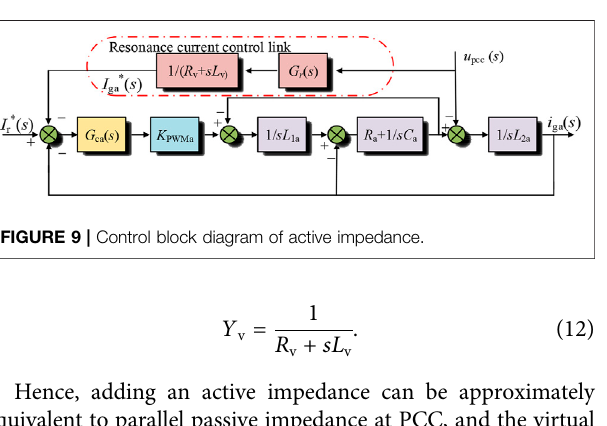
FIGURE 10 | Norton equivalent model of active impedance.